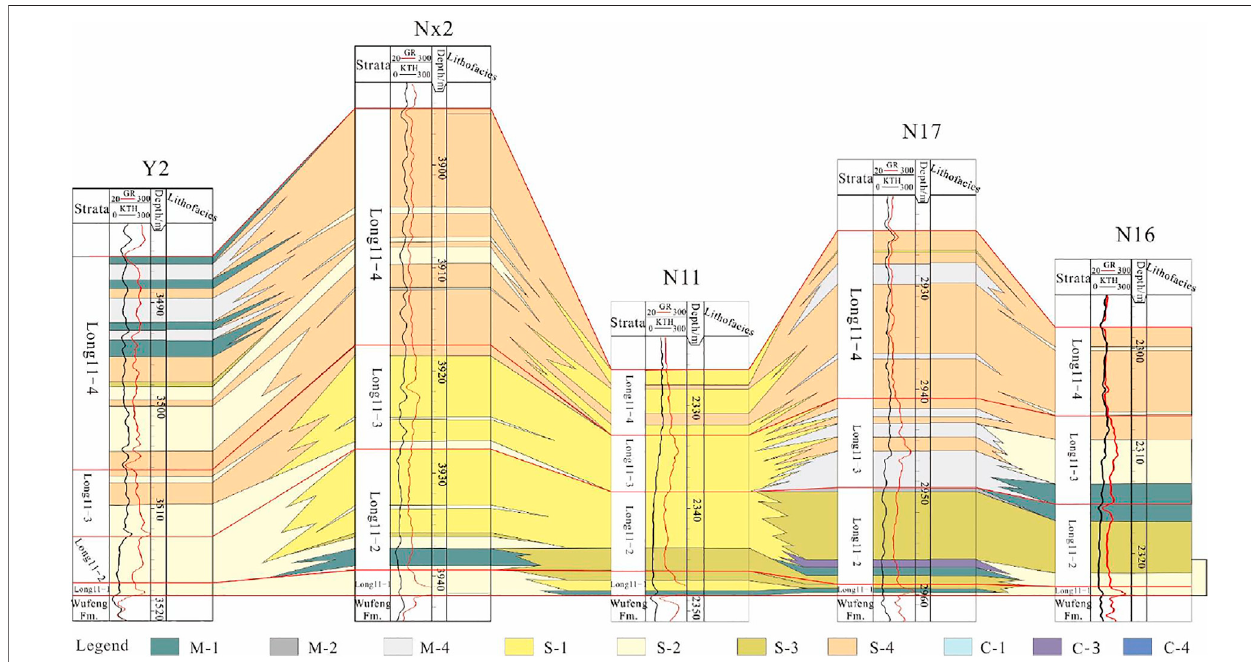
FIGURE 6| Cross section ofwells Y2 – NX2 – N11 – N17 – N16showing the lateral distribution characteristics ofthe shale lithofacies ofthe Longmaxi Formation in the Changning area.